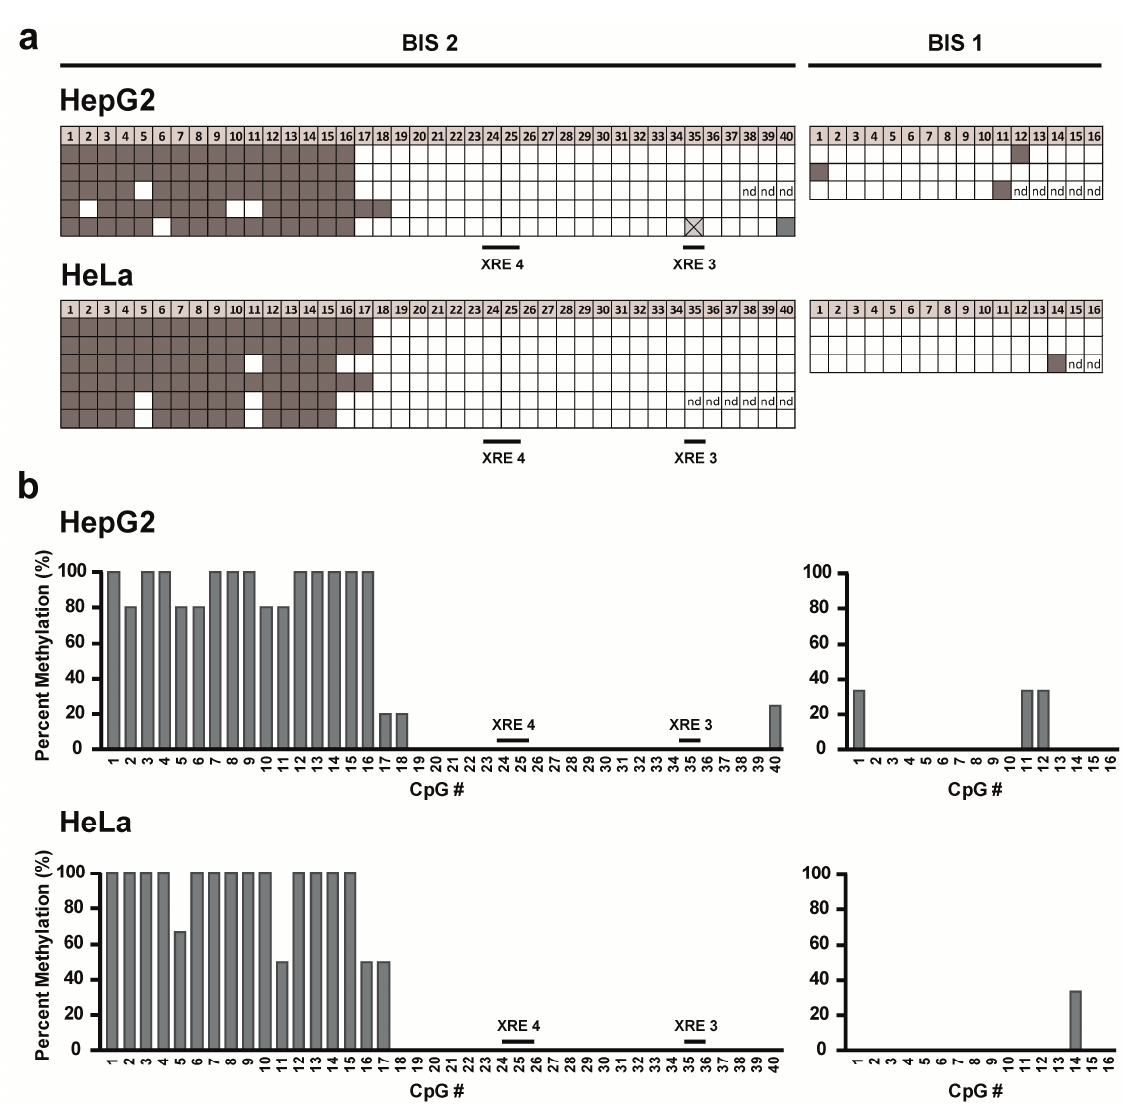
Figure 4. CpG DNA methylation of the CYP1A1 promoter in HepG2 and HeLa cells. Genomic DNA of HepG2 cells and HeLa cells was bisulfite converted and